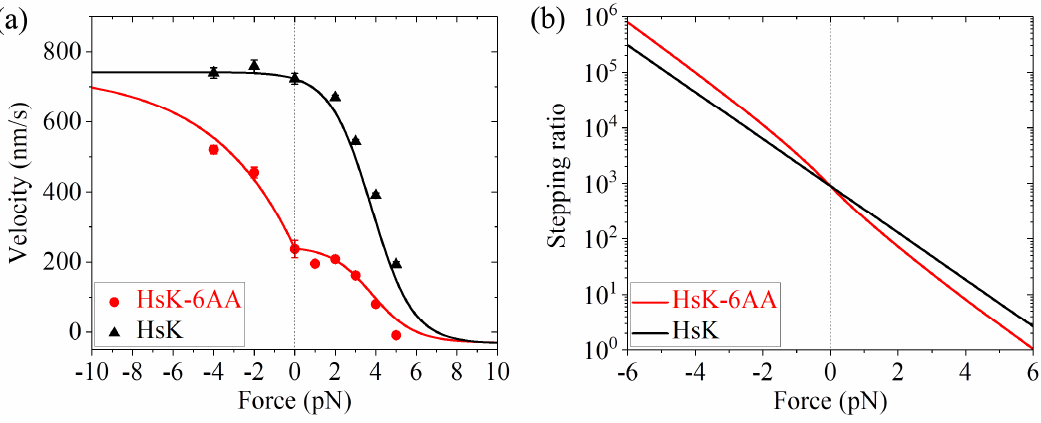
Figure 5. Dynamics of HsK and HsK-6AA at saturating ATP. ( a ) Velocity versus external force. Lines represent analytical solutions. Symbols are experimental data at 2 mM ATP taken from Andreasson et al. [24]. ( b ) Analytical solutions of stepping ratio versus external force.